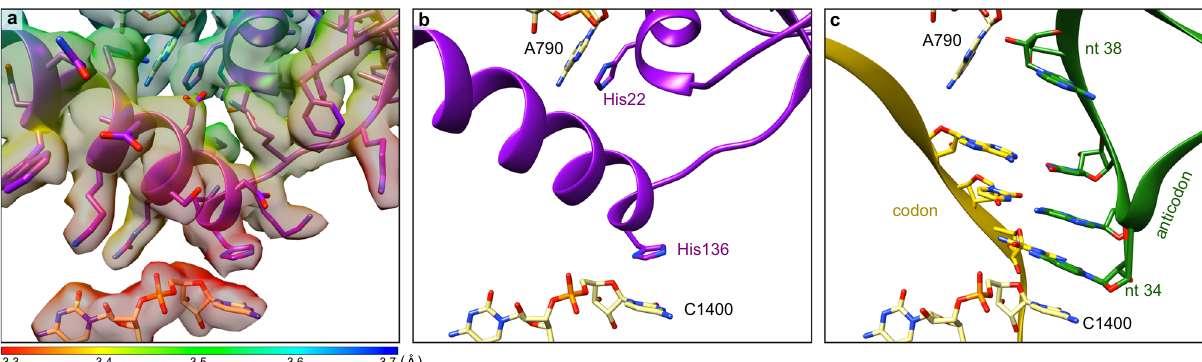
Fig. 7 SmpB mimics the interactions of a tRNA anticodon loop in the P site. a Focus on the interactions between SmpB and the 16S rRNA P-site in the translocation state. The cryo-electron density map is displayed and coloured according to the local resolutions as computed with ResMap 74 . b Same as ( a ), but without the map. For clarity, cartoon representation is used for SmpB and only His22 and His126 are shown. c Comparison with a P-site tRNA 30 (PDB code 7K00). The SmpB C-terminal tail occupies the mRNA path, replacing the codon – anticodon interaction. SmpB also reproduces the anticodon loop interactions with the 16S rRNA. The stacking interaction between His22 and A790 replaces the interaction usually observed with the sugar of tRNA ’ s nucleotide (nt) 38. Meanwhile, His136 replaces the anticodon ’ s nucleotide 34, stacking on the C1400 rRNA nucleotide. SmpB is purple, tRNA is green, mRNA is yellow and 16S rRNA is